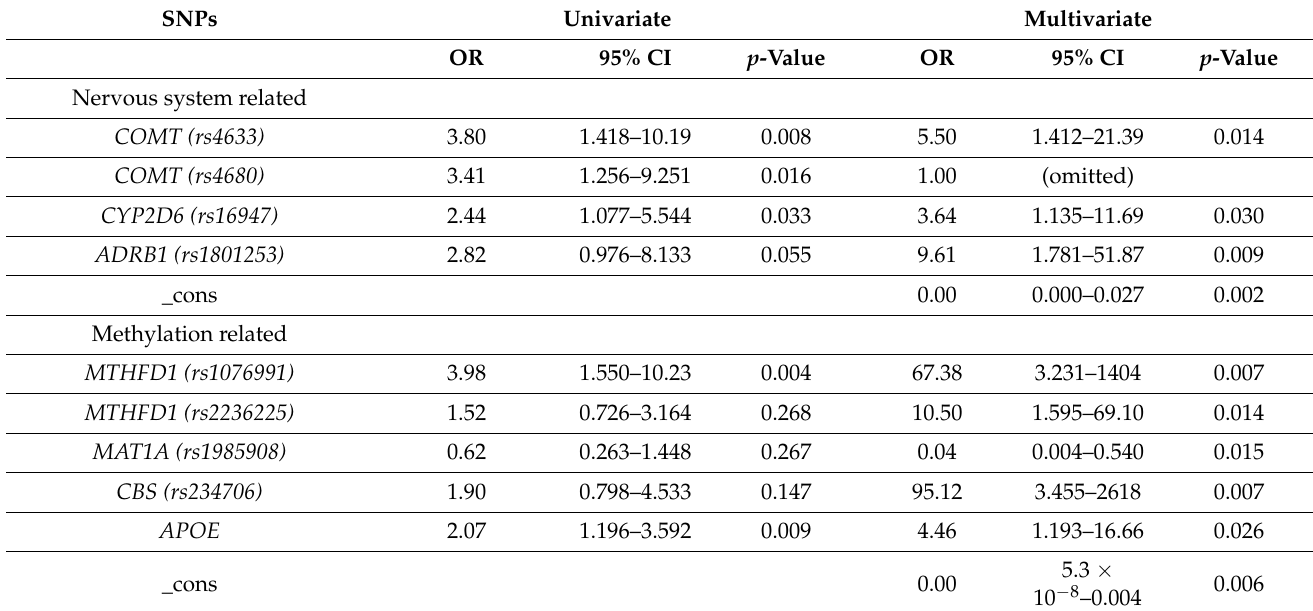
Table 3. Univariate and multivariate logistic regression of predictors of AD